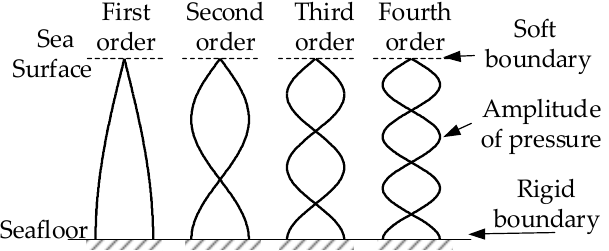
Figure 2. Amplitude of the pressure of normal mode wave of plane wave guide in shallow water on the wave guide cross section. Table 1. Comparative of present Ocean Bottom Seismometers (OBS) [18].